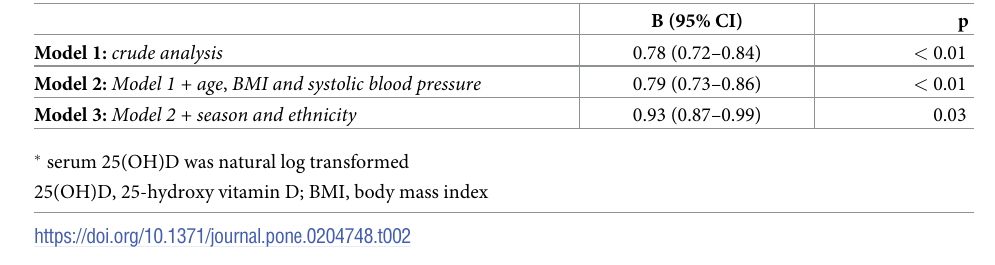
Table 2. Linear regression analysis of serum 25(OH)D � in PCOS versus fertile controls.